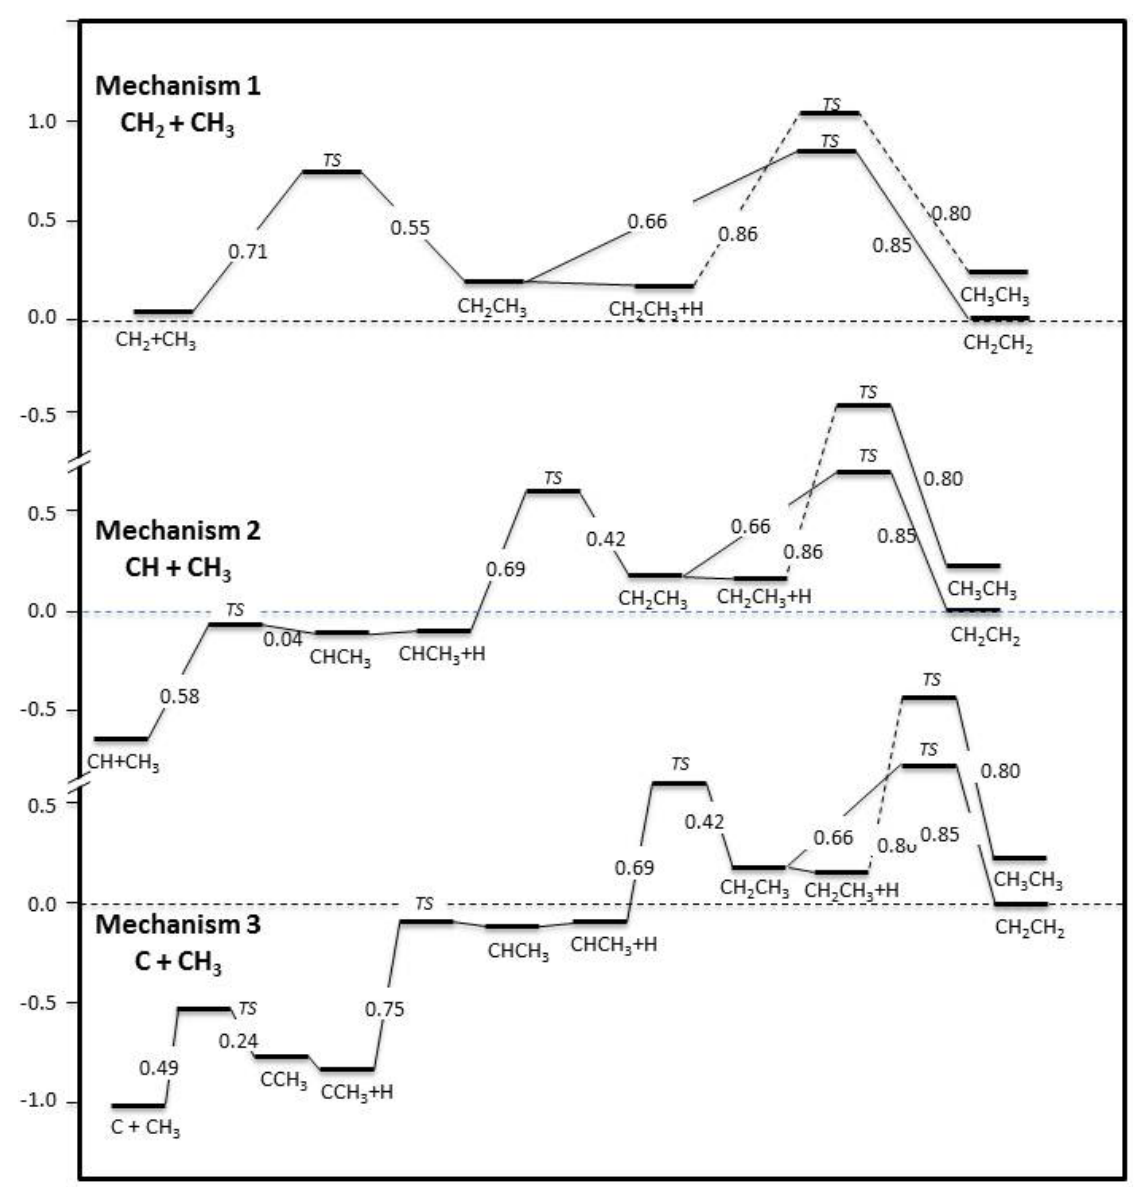
Figure 3. Detailed chemical potential profile characterising the three selected reaction mechanisms. The y -axis indicates energy in electronvolts